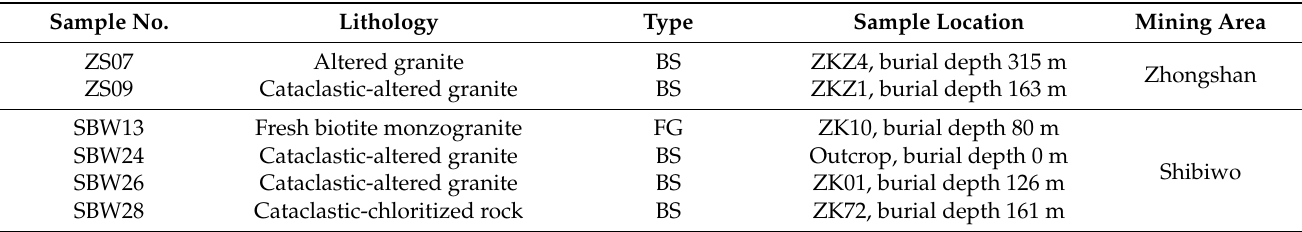
Table 1. Geological characteristics and location of the SJOF granite